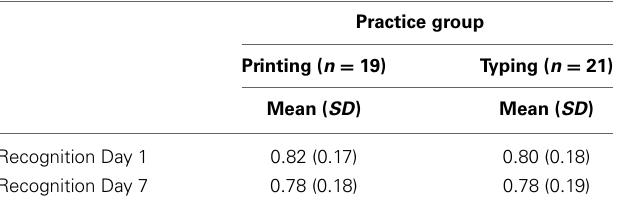
Table 2 | Proportions of target non-words selected on recognition